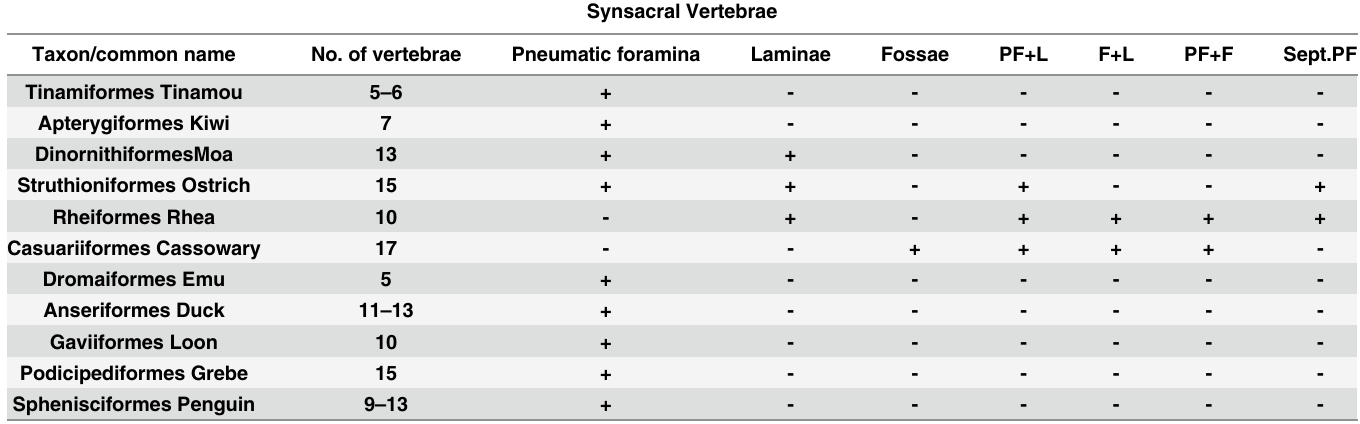
Table 4. Distribution of pneumatic elements of synsacral column per taxon. Presence (+) and absence (-) of pneumatic characters found on the synsa- cral vertebrae from specimens of the 11 taxa studied. The penguin with the pneumatised vertebrae is Pygoscelis papua (NHMUK unregistered). For more details see S1 Table and S3 – S13 Tables. Abbreviations: PF, pneumatic foramina; F, fossae; L, laminae; Sept.,